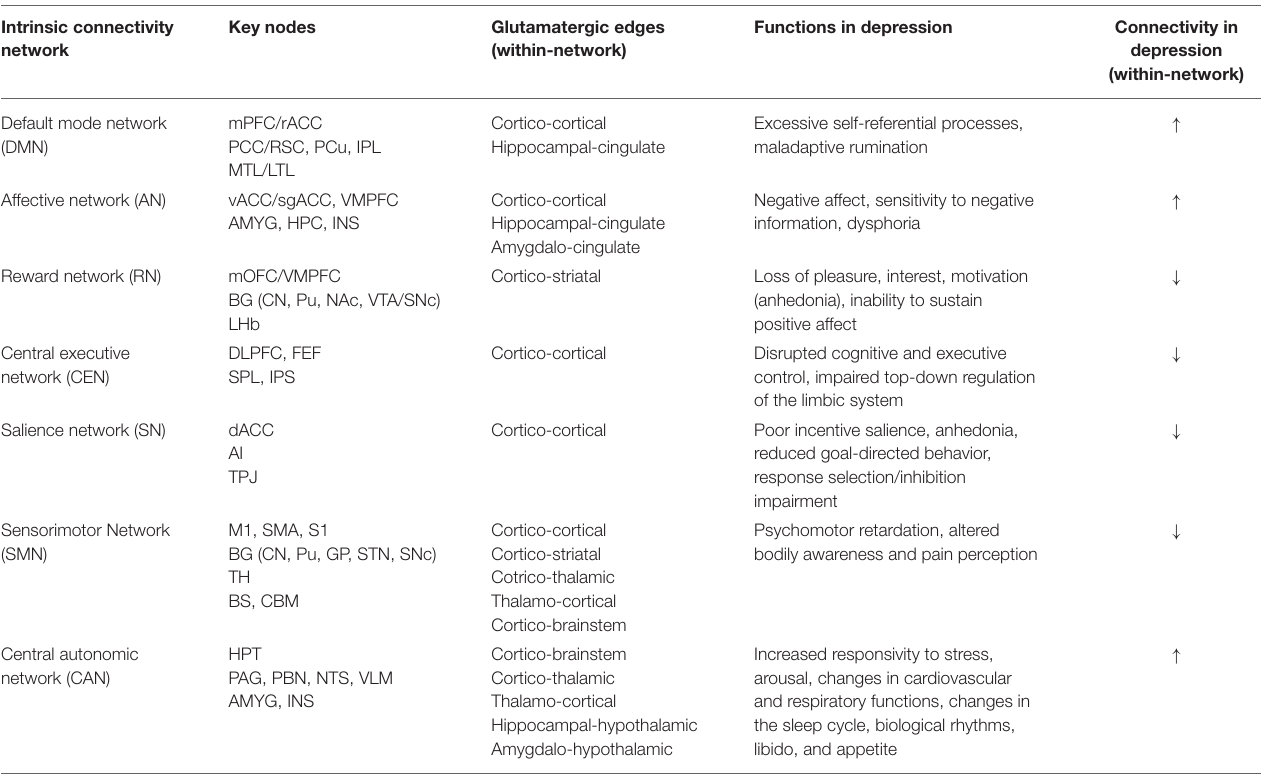
TABLE 2A | Anatomical and functional profile of glutamatergic intrinsic connectivity networks in depression. Intrinsic connectivity